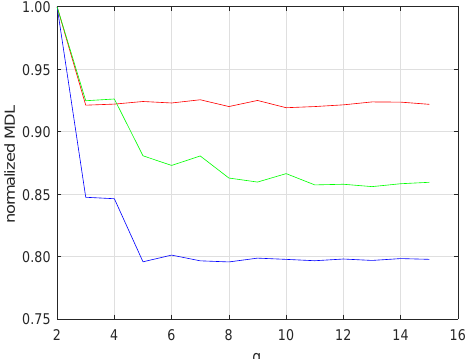
Figure 8. West point time series, Up component. Observed values (blue dots) and model (red